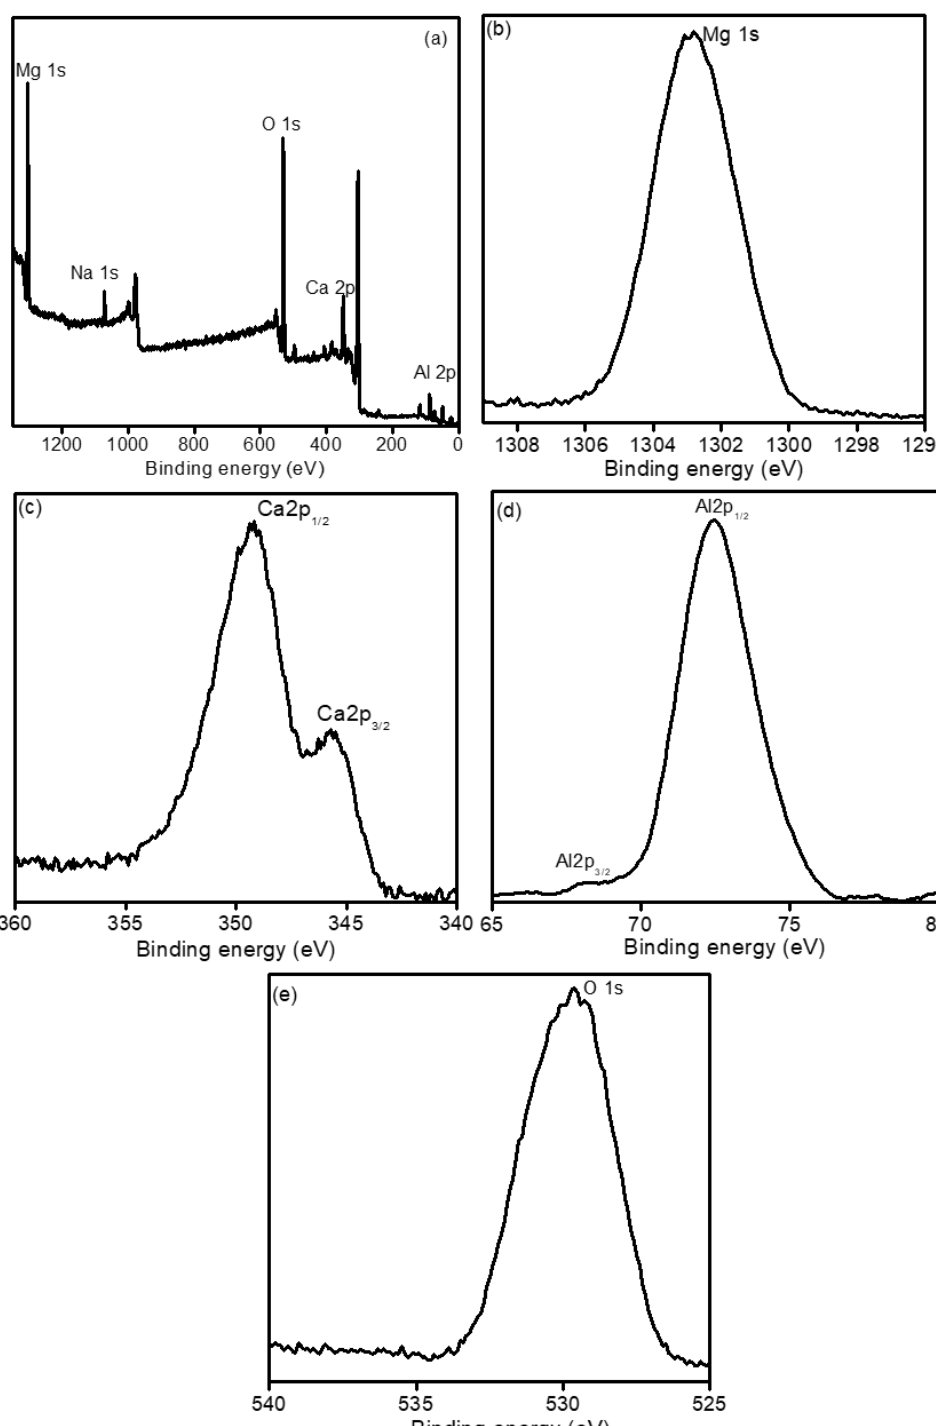
Figure 6. High-resolution XPS spectra of ( a ) survey, ( b ) Mg1s, ( c ) Ca2p, ( d ) Al2p and ( e ) O1s fresh Mg-Ca-Al-LDO mixed metal oxide composite.